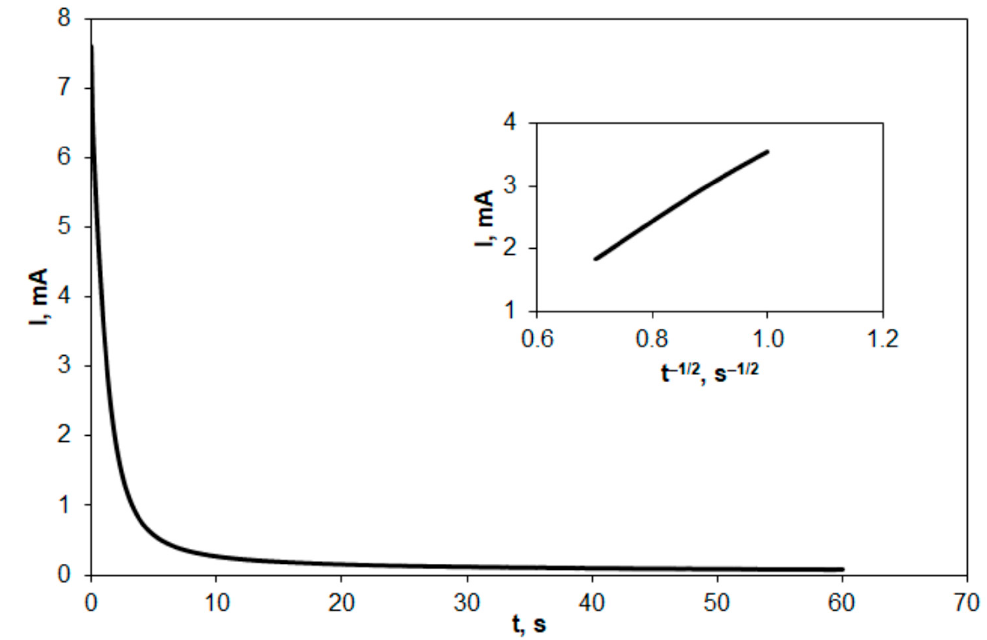
Figure 6. Exemplary chronoamperogram recorded at GFA in K 4 [Fe(CN) 6 ] (5 × 10 − 3 mol L − 1 in